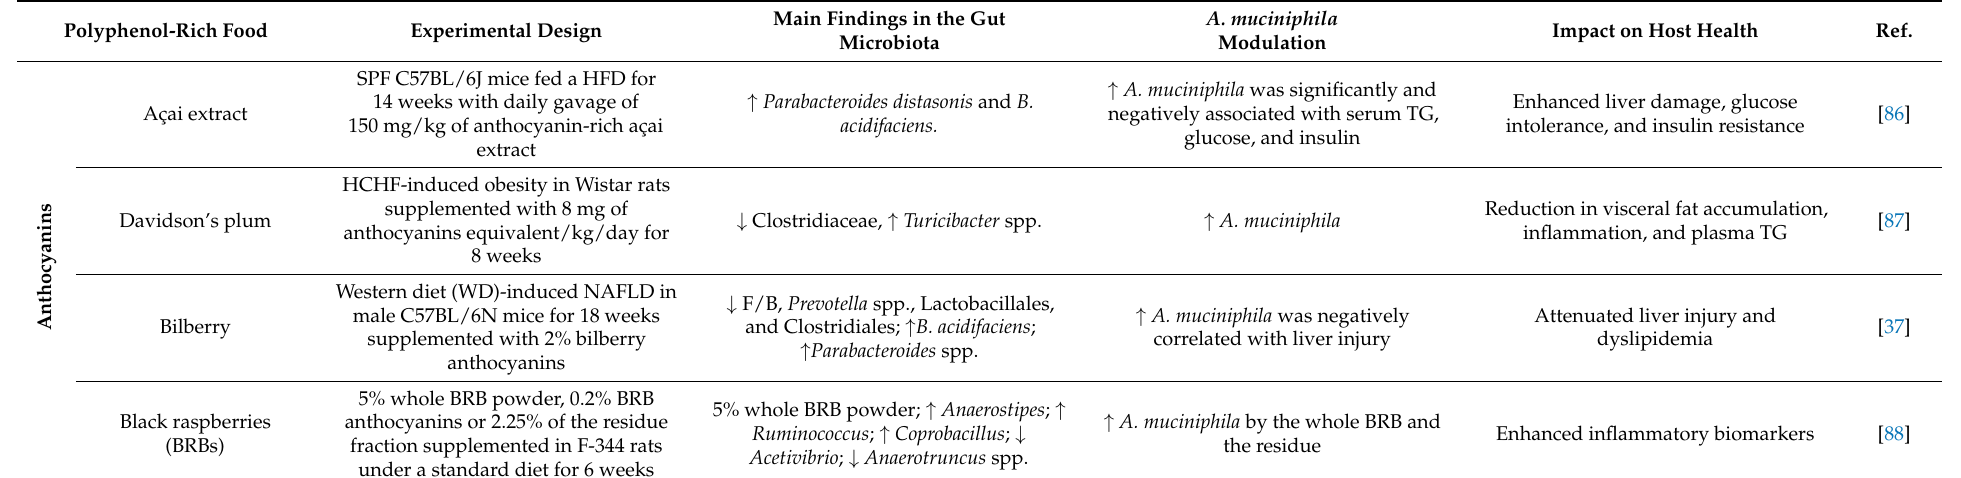
Table 1. Modulation of the gut microbiota by anthocyanin-rich foods in animal